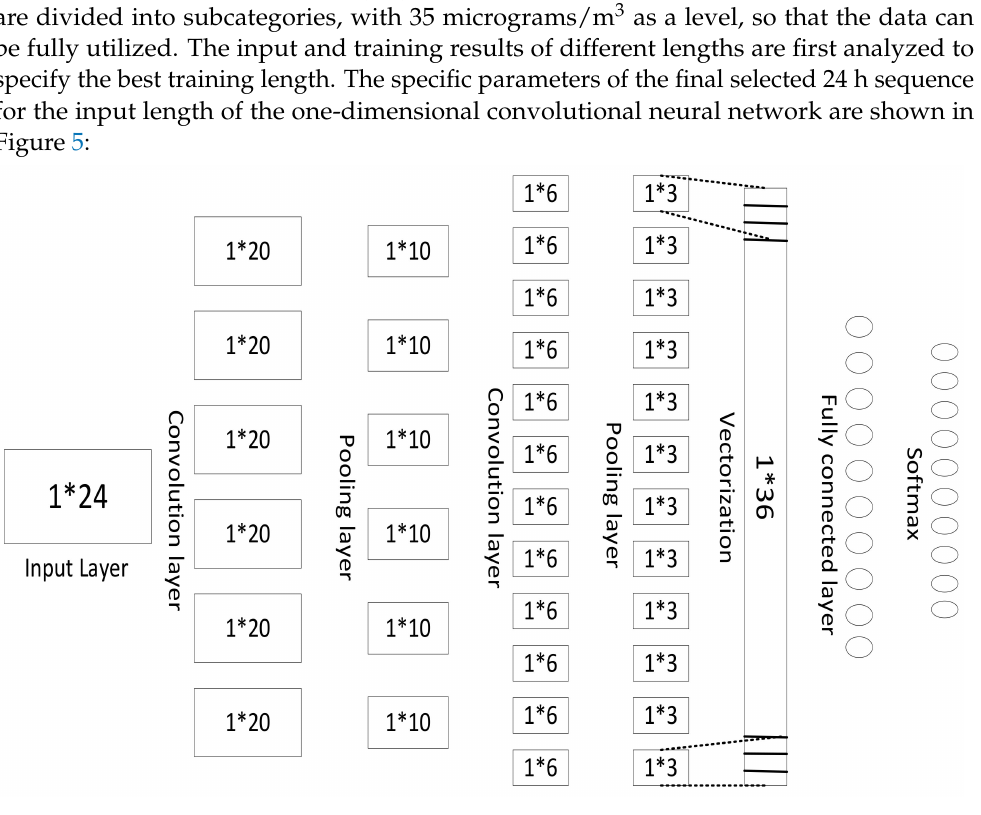
Figure 5. One-dimensional convolutional neural network predicts the specific structure of haze. From left to right: input layer; convolution layer; pooling layer; convolution layer; pooling layer; vectorization layer; connection layer;